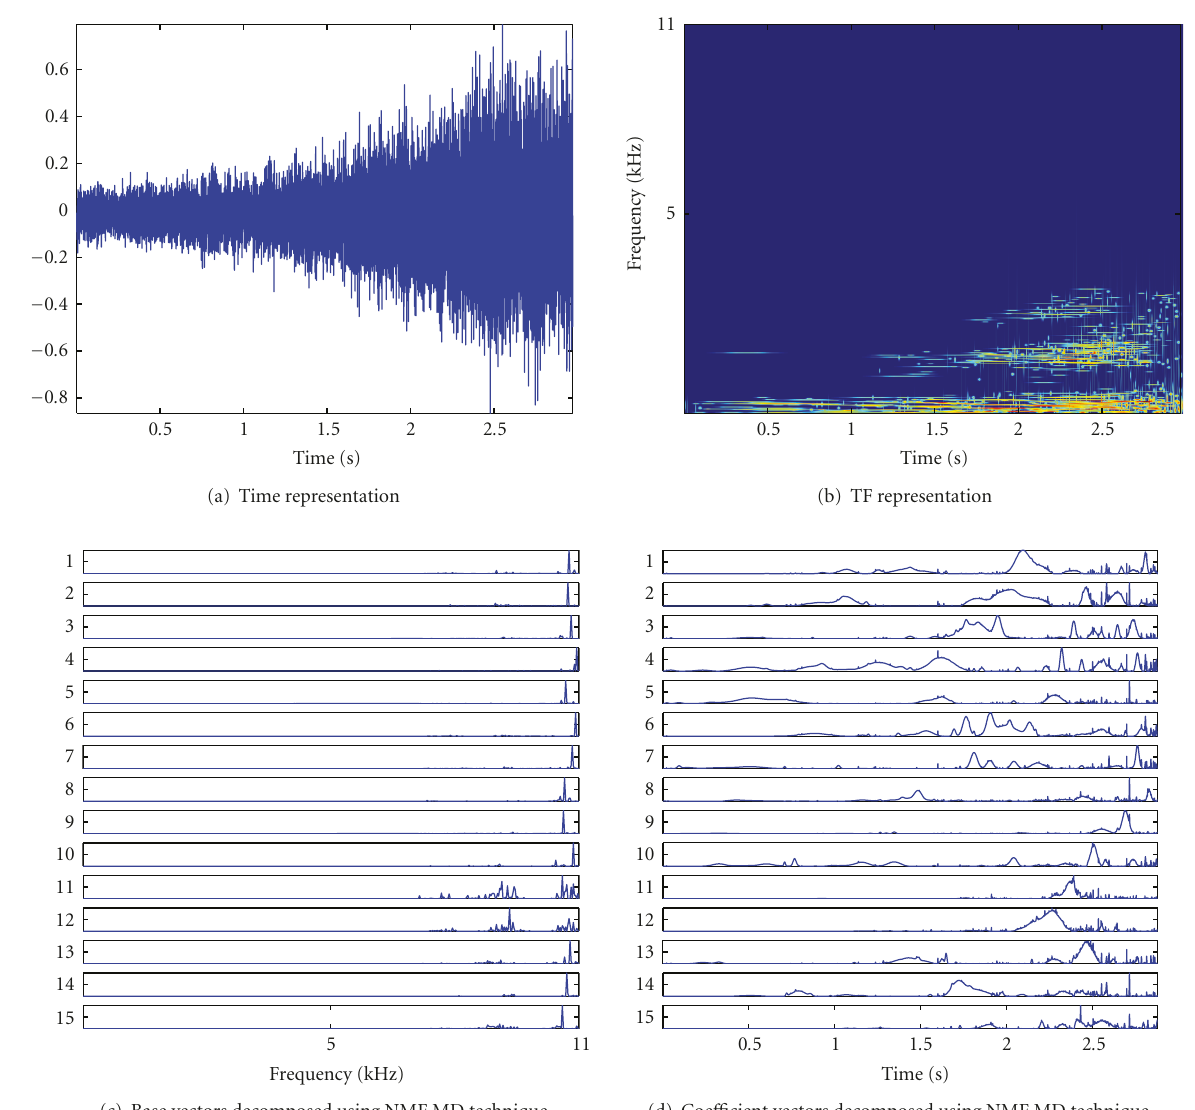
Figure 13: (a) and (b) show a segment that belongs to an aircraft signal in time and TF representations, respectively. Applying NMF to the TF matrix, we extract 15 base and coe ffi cient vectors which are depicted in (c) and (d),